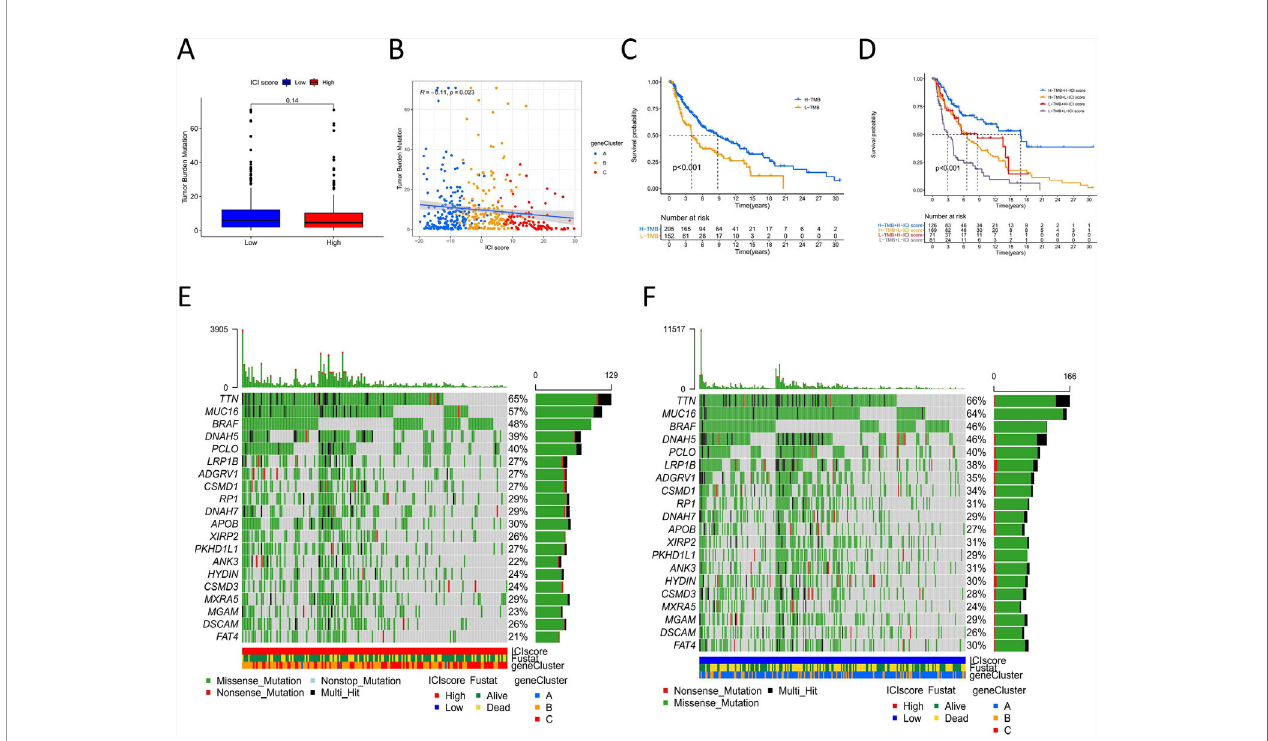
FIGURE 4 | The correlation between ICI score and cancer somatic variants. (A) TMB difference among the high and low ICI score groups. (B) The correlation Scatter plots between TMB and ICI score. (C) Kaplan-Meier curves of overall survival for high and low TMB group. Log rank test P <0.001. (D) Kaplan-Meier curves of overall survival strati fi ed by both TMB and ICI scores. Log rank test P <0.001. (E, F) The oncoPrint of high (left) and low (right)ICI score. Individual patients represented in each column. Missense mutation: green; Nostop mutation: gray; Nonsense mutation: red; Multi-hit: black. The top bar plot represented TMB. The right bar plot shows the mutation frequency of each gene in separate ICI score groups. The below bar represented ICI cluster, gene cluster and survival